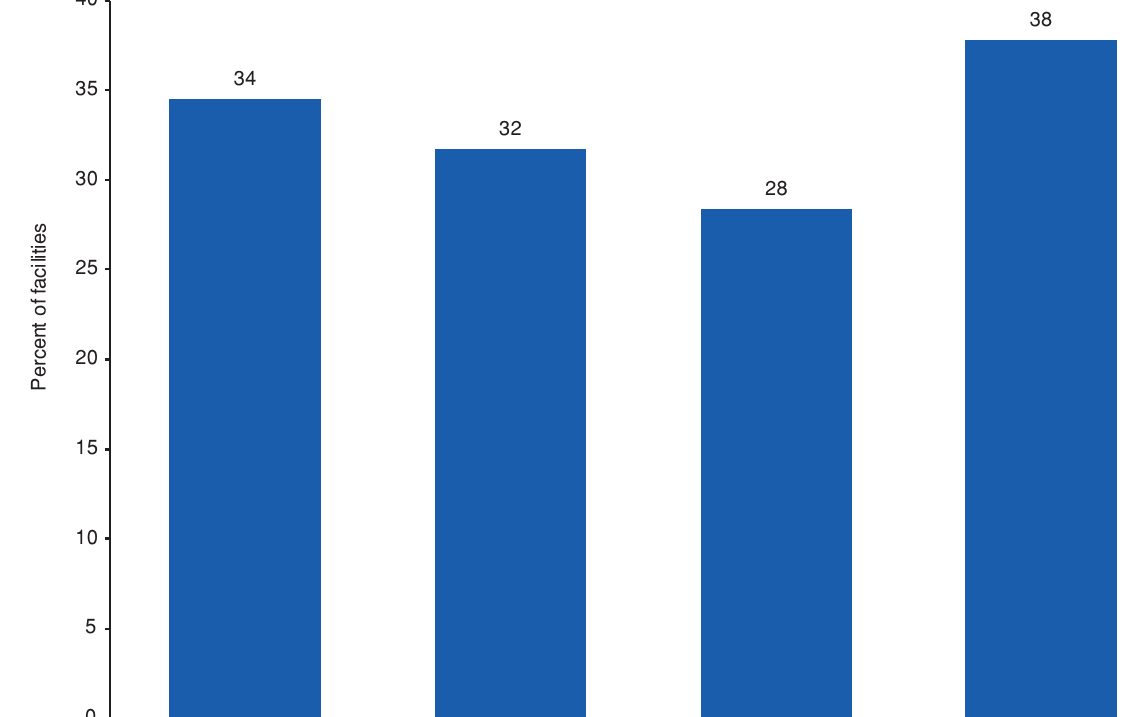
Figure 12. Mental health treatment facilities offering dedicated or exclusively designed treatment programs or groups for individuals with post-traumatic stress disorder, by region: